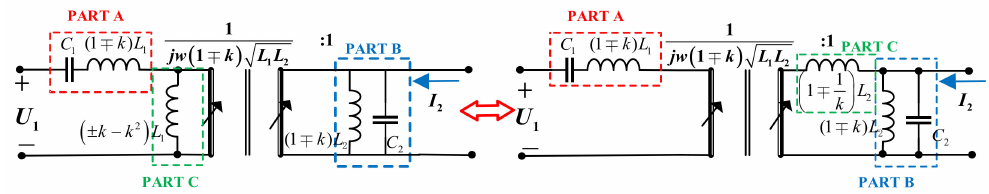
Figure 13. The equivalent model of the III_CV_CC circuit. Table 2. Modeling of constant voltage to constant current for loosely coupled transformers. Classification